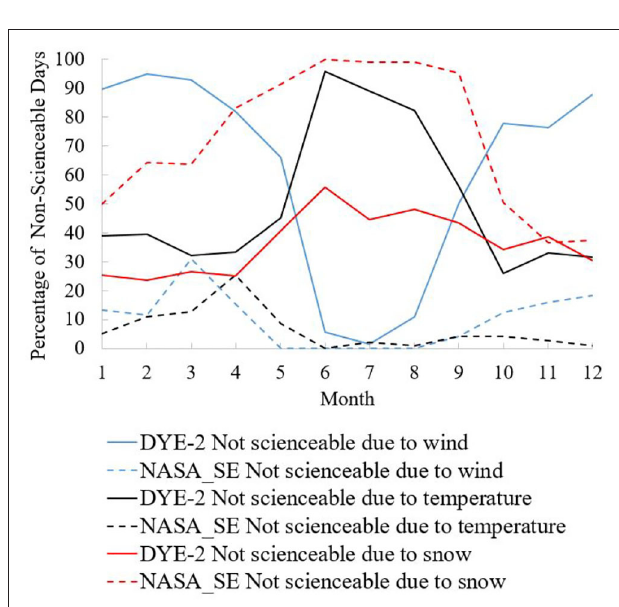
FIGURE 4 | Attribution of non-scienceable days at the DYE-2 and NASA_SE sites due to wind speed (blue), temperature (black), and snowfall (red). DYE-2 had 3910 non-scienceable days (64% of total days) whereas NASA_SE had 1893 non-scienceable days (48% of total days).